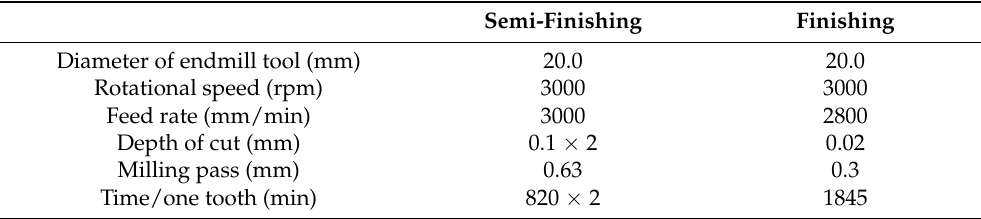
Table 2. Cutting conditions for semi-finishing and finishing operations in worm manufacturing. Semi-Finishing Finishing Diameter of endmill tool